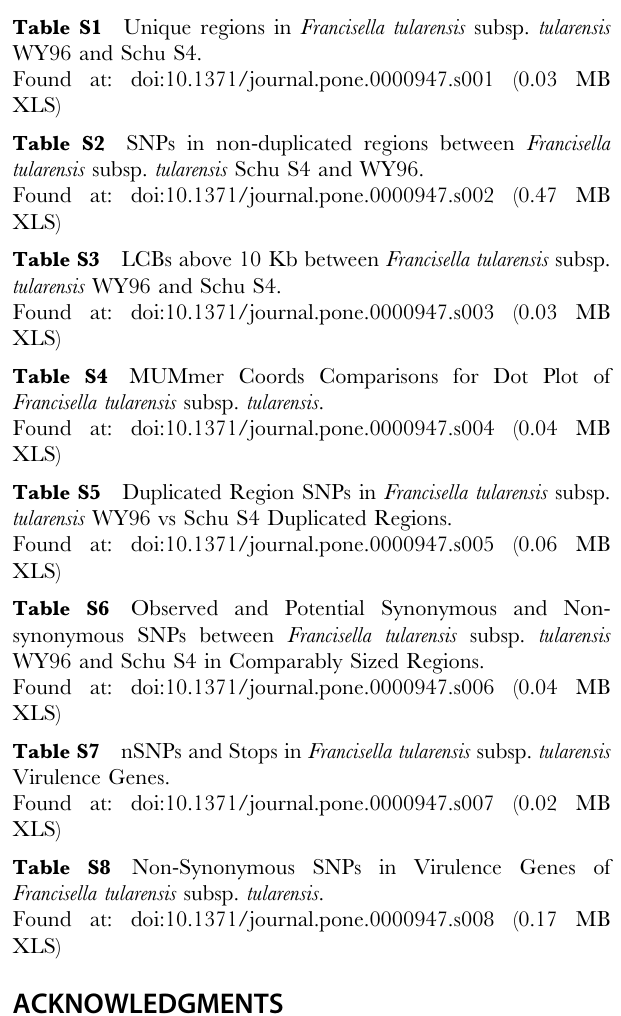
Table S1 Unique regions in Francisella tularensis subsp. tularensis WY96 and Schu S4.